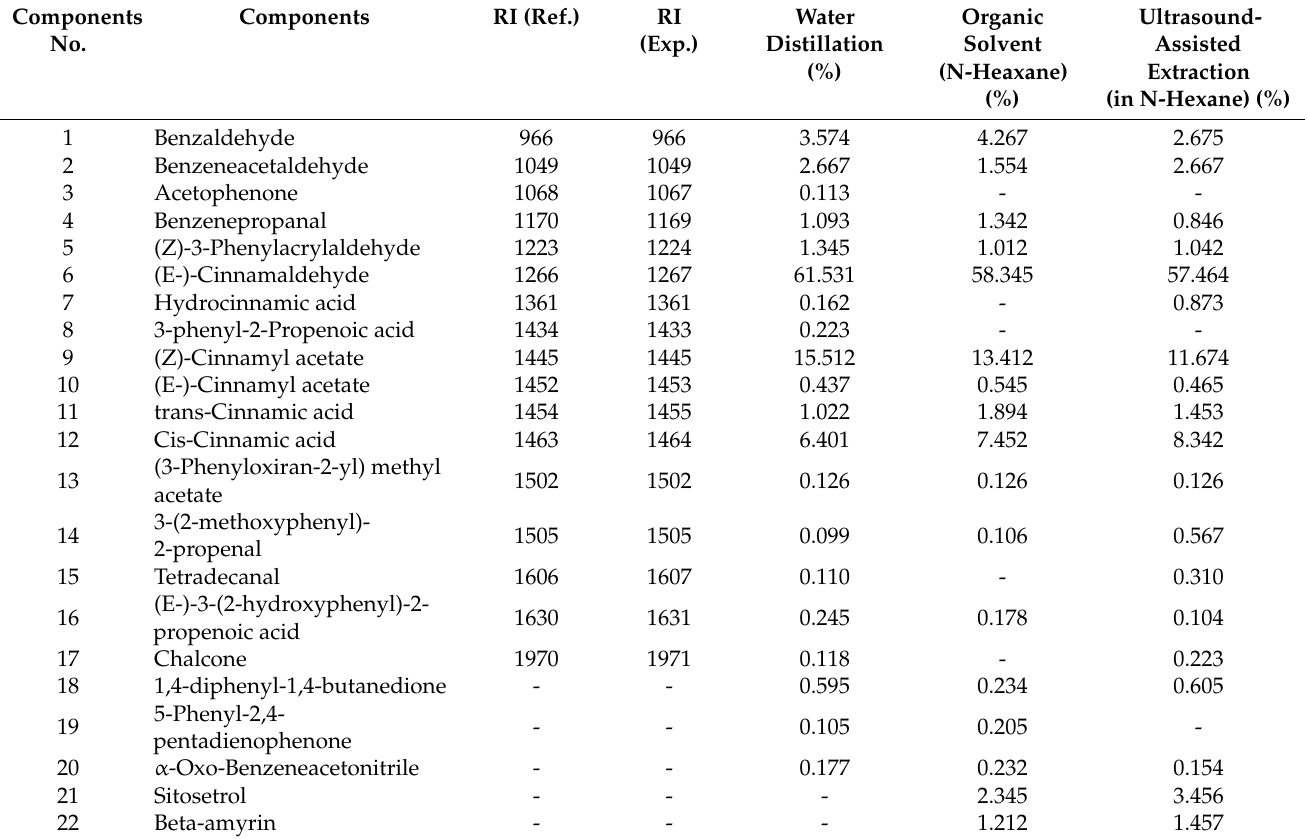
Table 1. Chemical components of C. verum bark EOs extracted by different extraction methods.